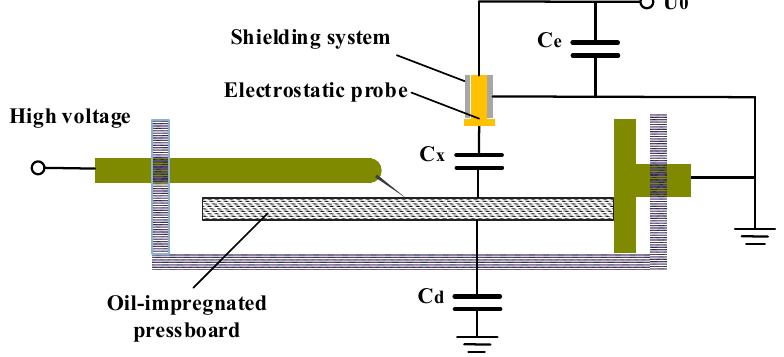
Figure 4. Schematic of TSDC measurement.